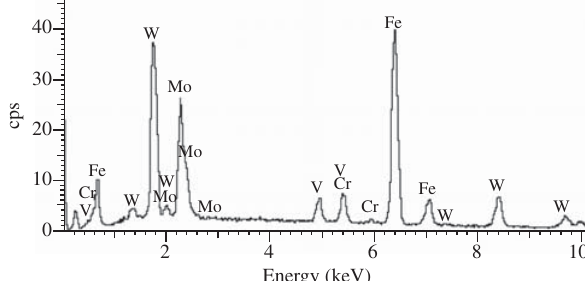
Figure 6. EDS microanalysis of M6C type carbide.